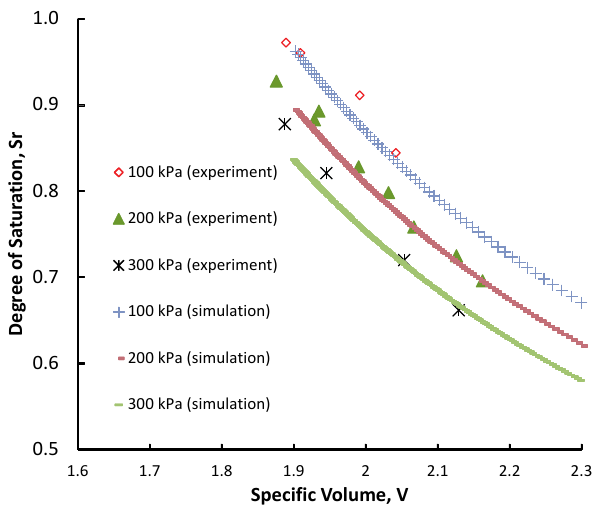
Fig. 3. Degree of saturation against specific volume in triaxial tests at constant suction – experimental results (Shivkumar [28]) and numerical